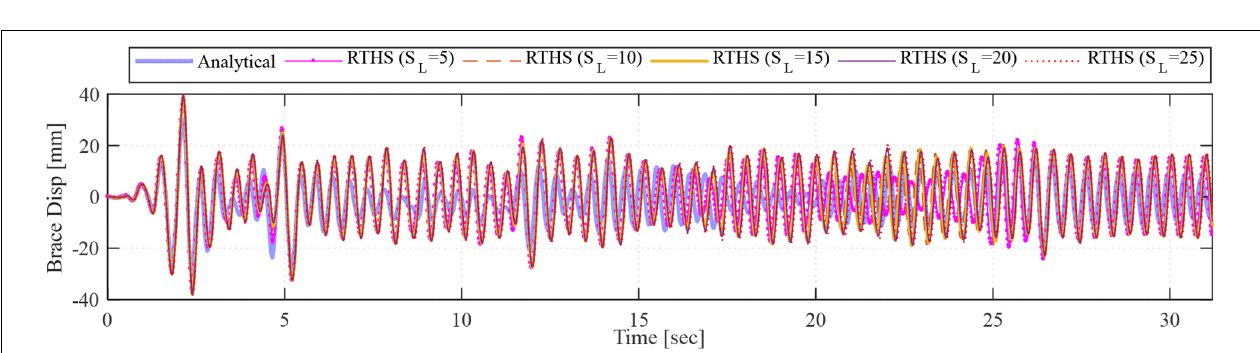
FIGURE 16 | Brace displacement response time histories for different ρ ∞ parameter values along with NRMS errors with respect to the implicit Newmark method.